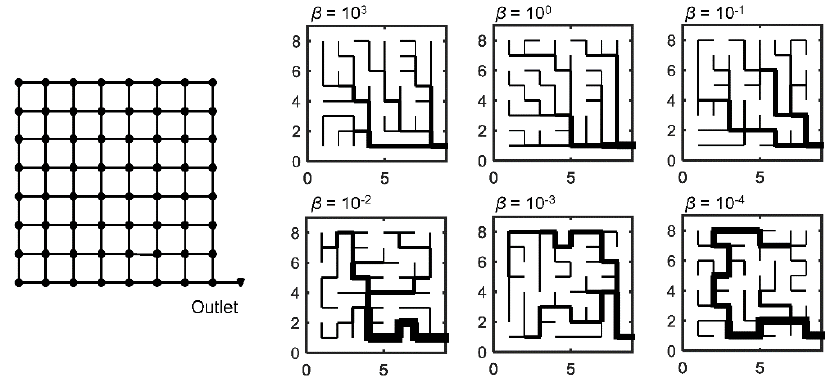
Figure 2. A synthetic rectangular catchment composed of 8 × 8 grids and dendritic networks generated by the Gibbsian model: what would behave like the fully looped